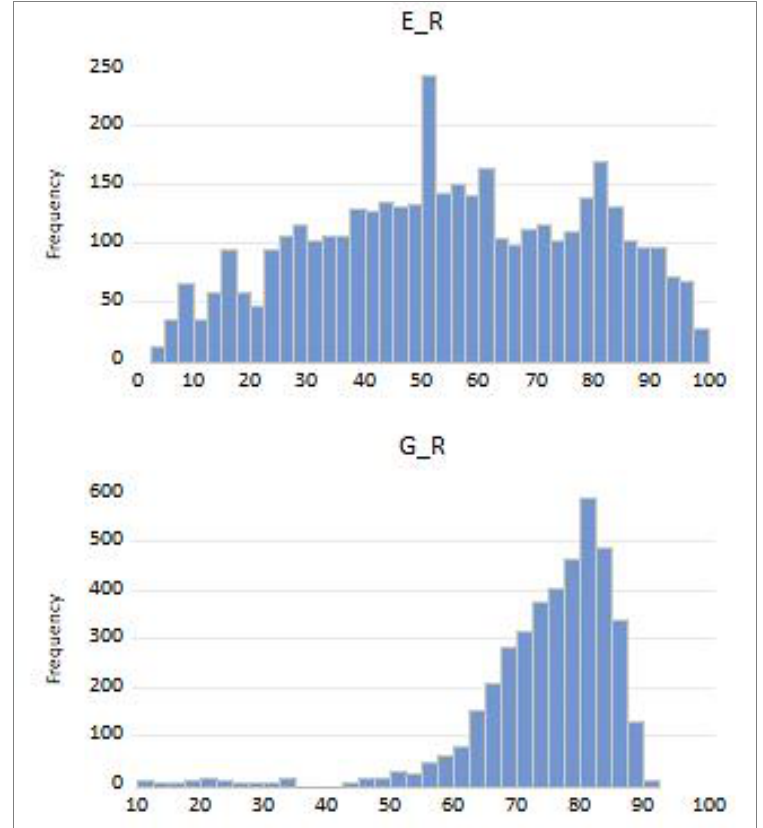
Figure 2. Statistical distribution function of E score and G score (EViews)